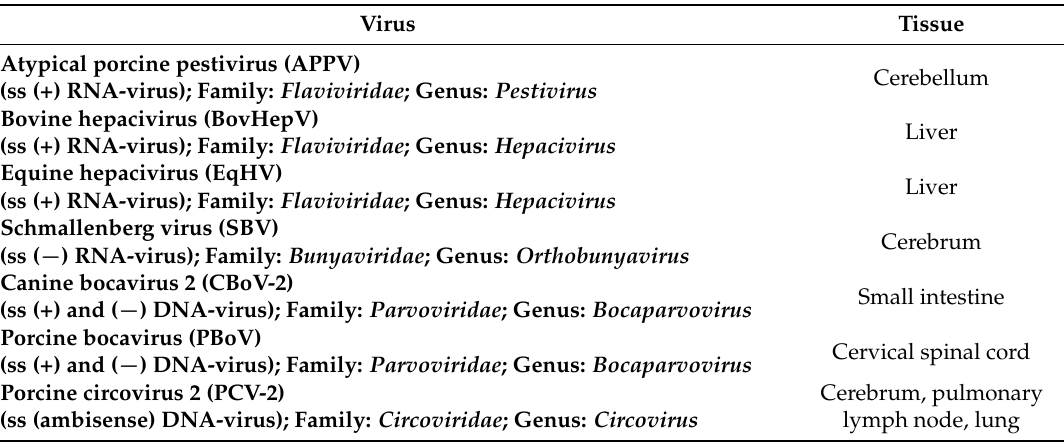
Table 1. Overview of investigated viruses and